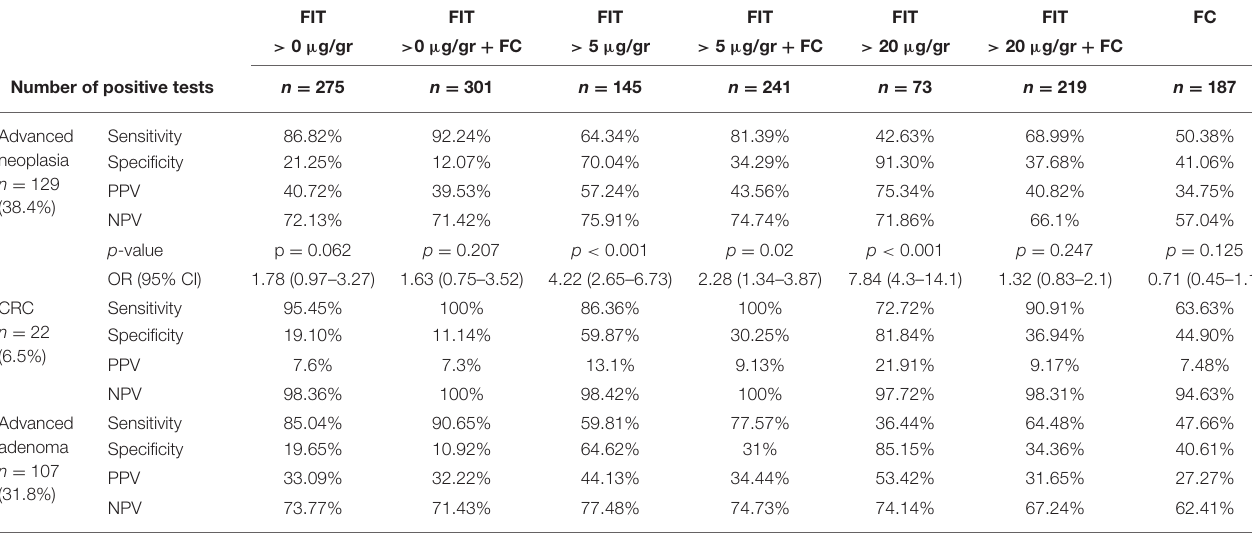
TABLE 1 | Diagnostic accuracy of quantitative FIT, FC and its combination.